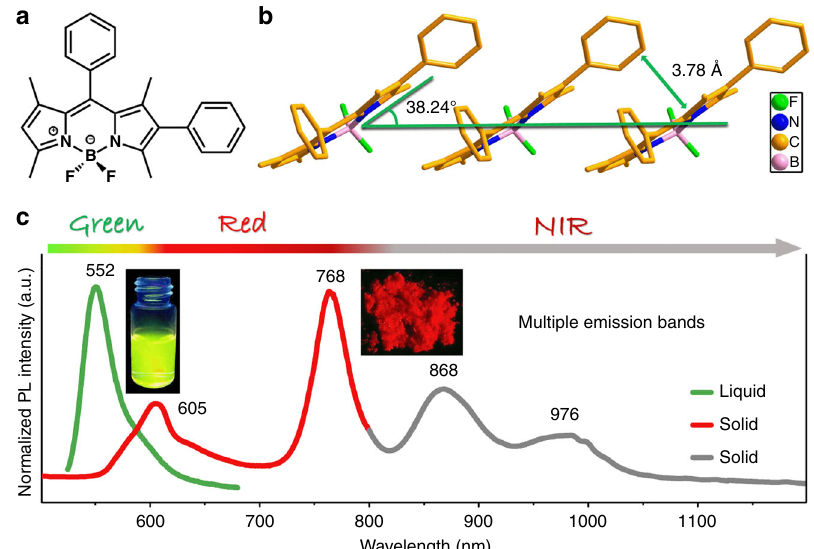
Fig. 1 Structural details and fl uorescent properties of BDP1. a Molecular structure of BDP1. b Molecular packing diagrams of BDP1 at room temperature extracted from single crystal XRD data. c Normalized photoluminescence (PL) spectra of BDP1 in solution (green curve) and microcrystalline powder state (red and gray